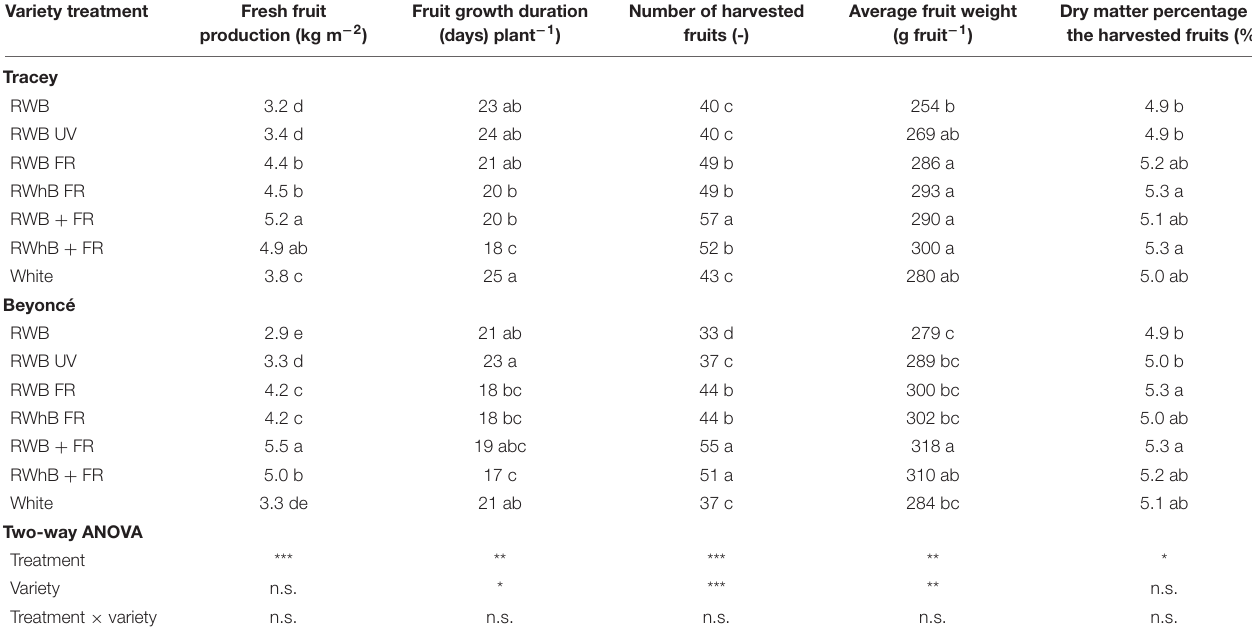
TABLE 3 | Effects of spectral composition on fruit production of eggplant.